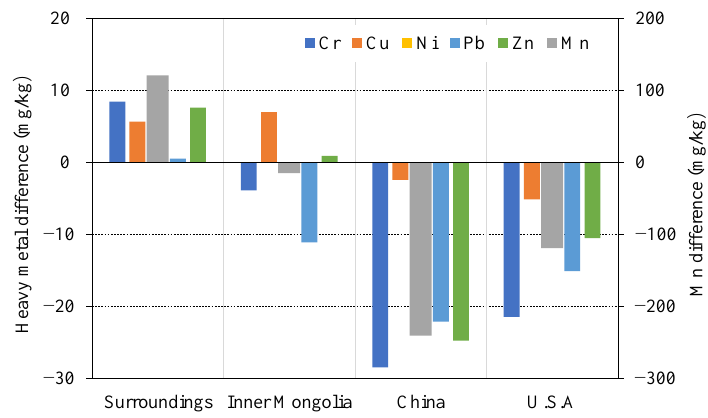
Figure 2. Statistical analysis of heavy metals in soil of mining area.